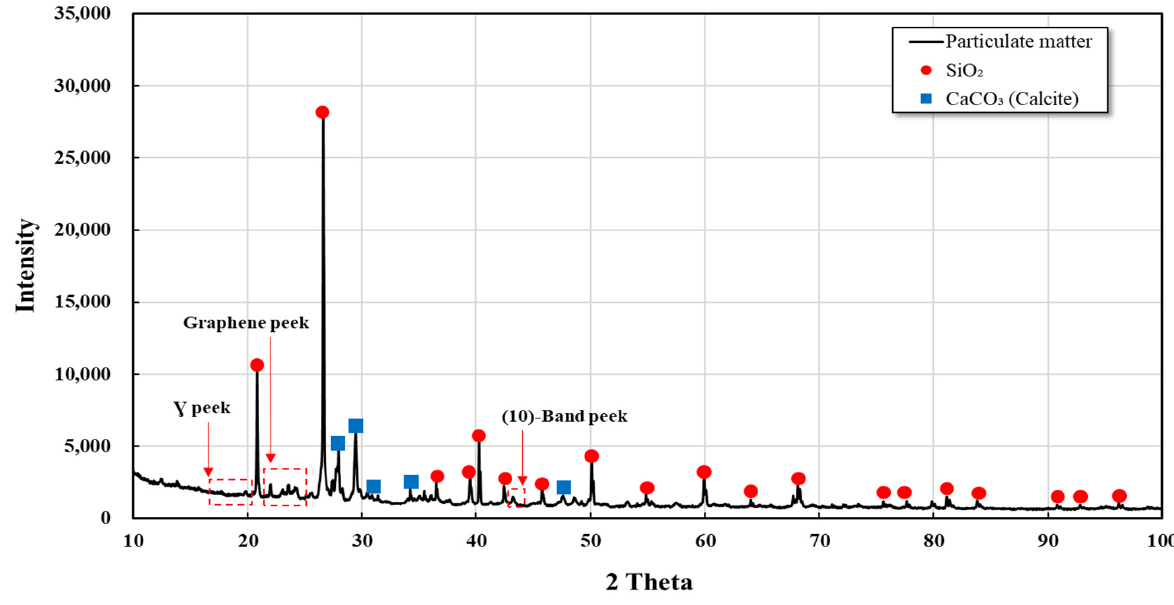
Figure 11. X-ray diffraction analysis of PM obtained from asphalt concrete cutting.